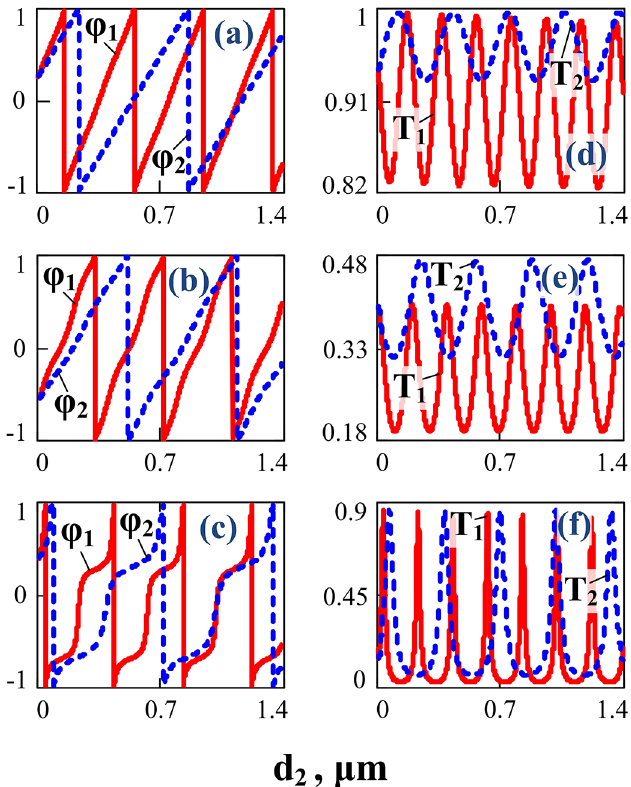
Fig. 2. Dependences of phases ’ 1,2 (a – c) and energy transmission coef fi cients T 1,2 (d – f) of waves 1, 2 on the main layer thickness d 2 for various materials of layers 1, 3. The values of parameters are: (cid:1) 3 i (a,d); e (cid:1) 3 i , e e e 1 = 3 =2+ 10 1 =2 +10 3 =0.01 +0.01 i (b,e); e e 1 = 3 =0.01 +0.01 i (c,f). The values of parameters for all the graphs are: d 1,3 =0.25 m m, l = 0.63 m m. Parameter d 2 is used as the abscissa axis for all the